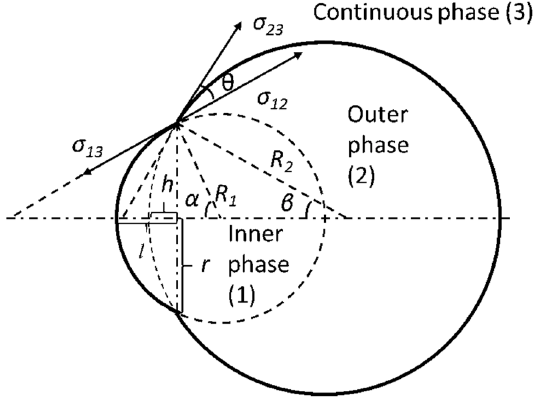
Figure 2. Schematic of the dewetting process of a double-emulsion droplet. Phases (1), (2) and (3) are inner, outer and continuous phases, respectively; σ ij is interfacial tension between phase i and j ; R 1 and R 2 are the radii of inner and outer phases, respectively; r is the radius of a cycle formed by three-phase contact line; l is the length of phase (1) out of phase (2); h is the virtual height of phase (2) in phase (1).